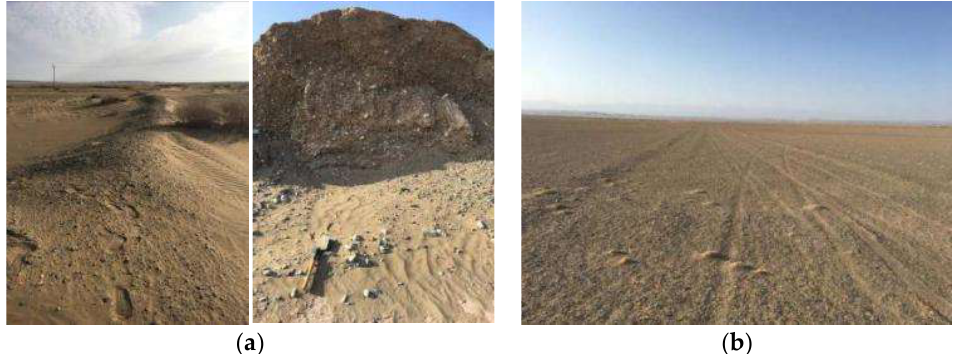
Figure 10. Destroyed dam on the Honggou and a 10-m-wide abandoned road found during the field investigation. ( a ) Field photo of the destroyed dam across the dried-up watercourses; ( b ) field photo of the abandoned road discovered near the dried-up watercourses.